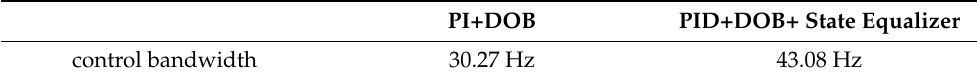
Figure 13. Control bandwidth comparison diagram. Table 2. Performance comparison before and after